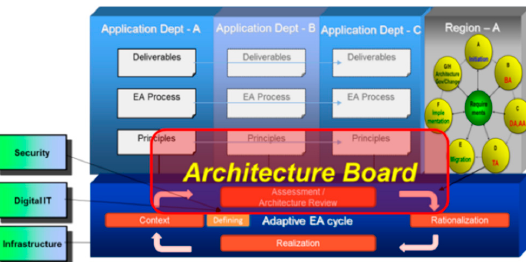
Figure 5. Adaptive Integrated Digital Architecture Framework (AIDAF) proposed model with Architecture Board (ex: TOGAF and adaptive EA framework) [5,38]. Architecture Board (ex: TOGAF and adaptive EA framework)